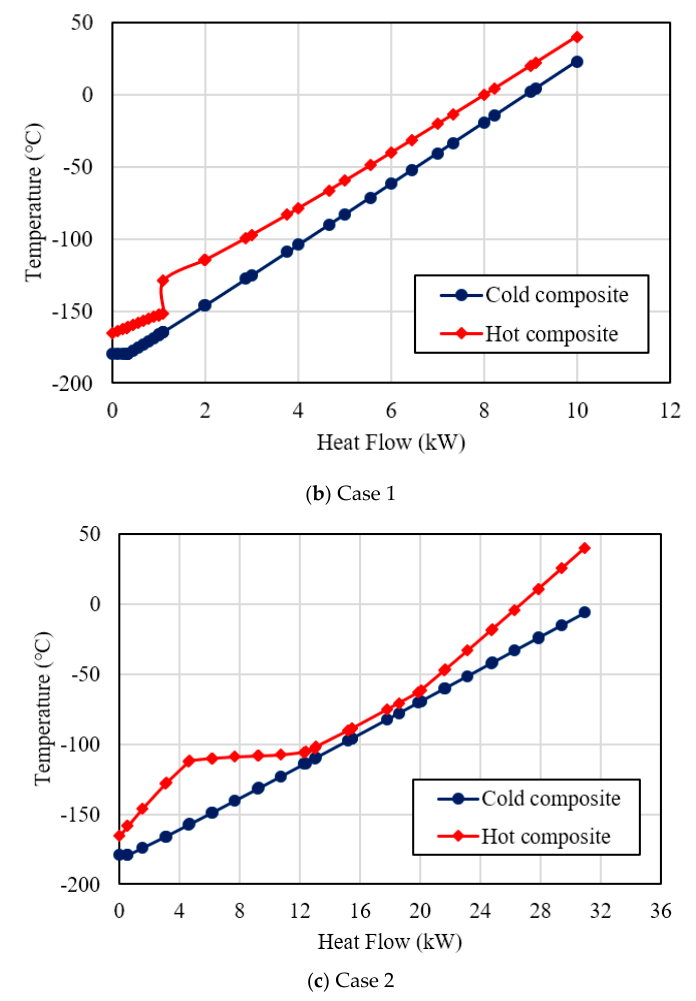
Figure 12. Composite curves of the MCHE: ( a ) Base case, ( b ) Case 1, ( c ) Case 2.